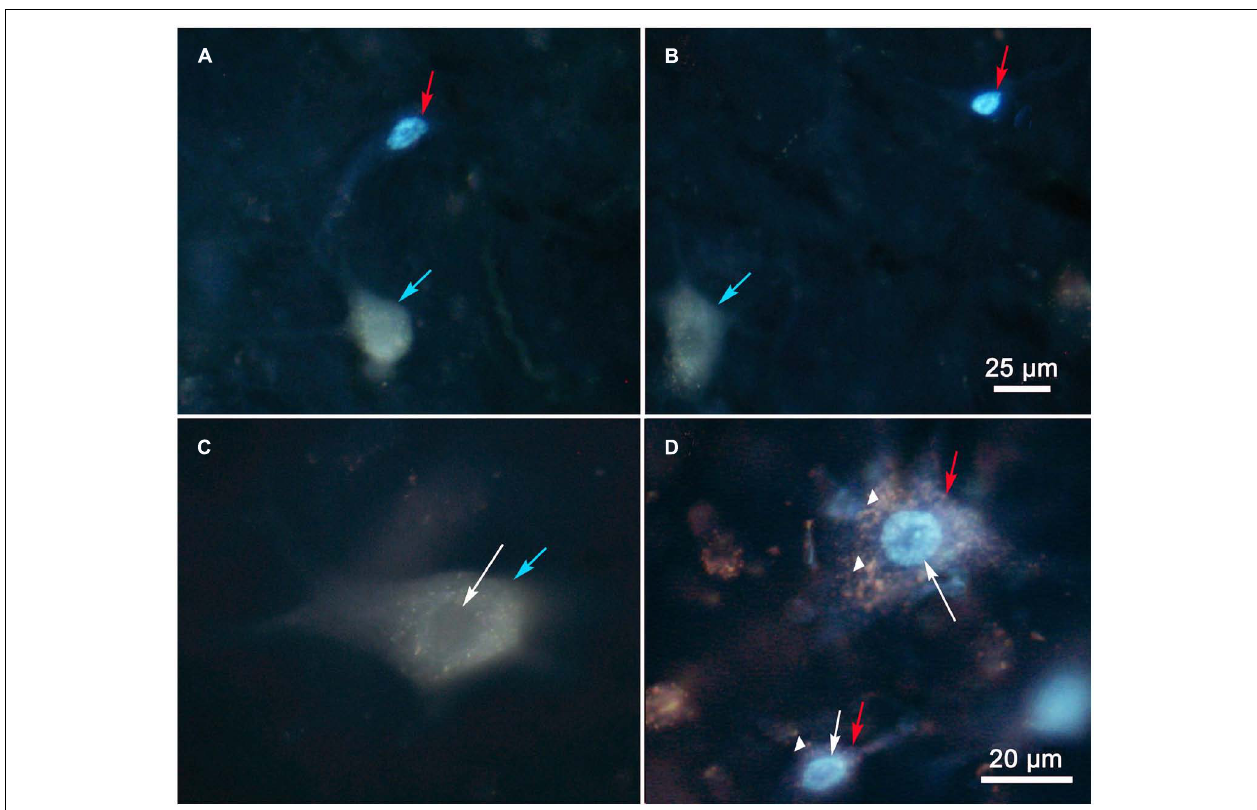
in the MRF. Higher magnification (C) of a FG labeled reticulotectal neuron (blue arrow) shows the nucleus (white arrow) is unlabeled compared to the nucleus (white arrow) of the DY labeled cell (red arrow) in (D) .The cells in (D) are DY labeled neurons that contain lipofuscin (arrowhead) in their